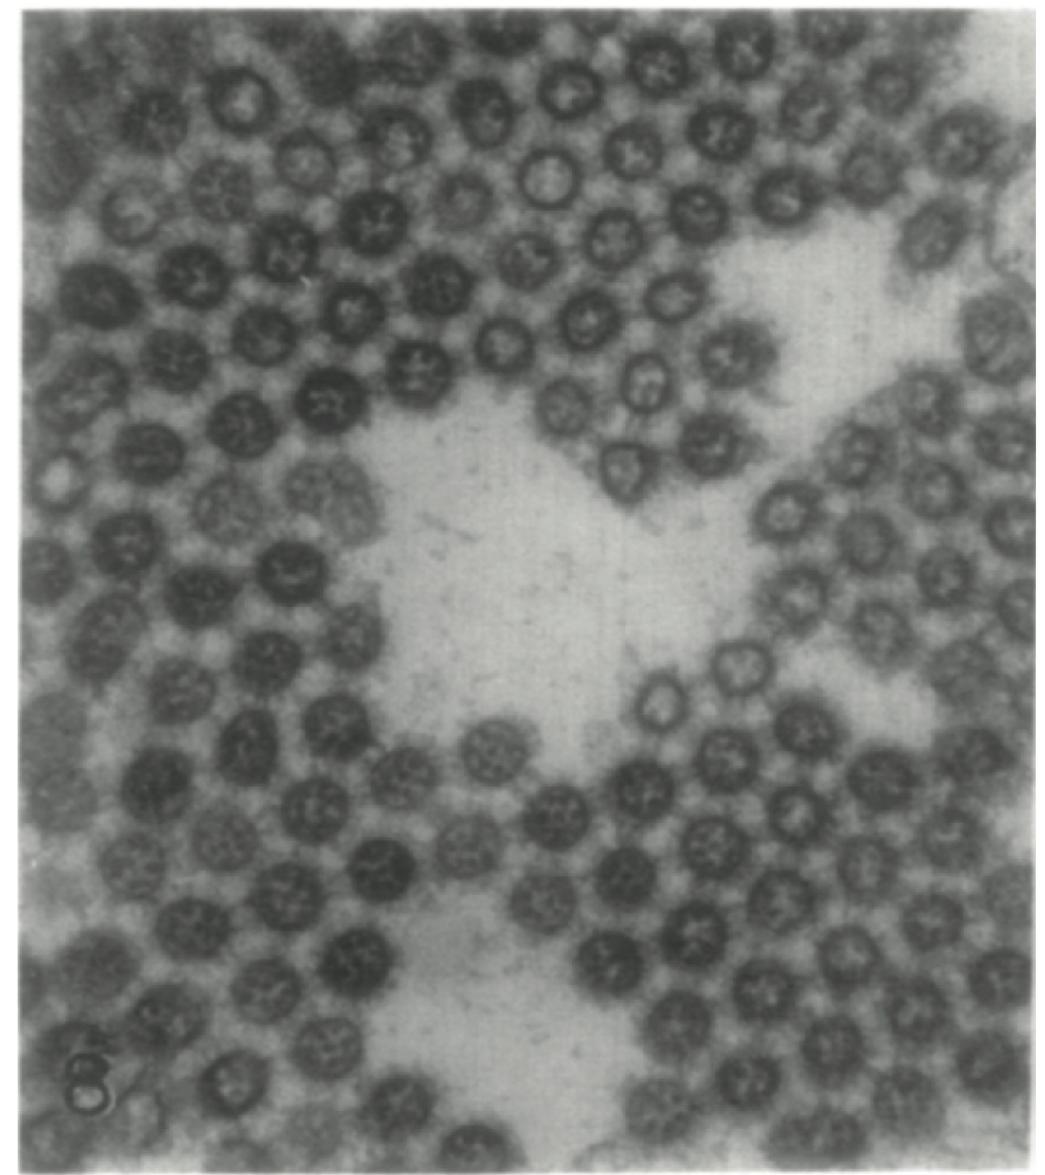
Figure 4. NA is needed for the successful detachment of nascent influenza virus particles from host cells. Shown here is one of the original electron micrographs from the work of Peter Palese et al. (taken with permission from P Palese, Tobita, et al. , 1974), showing the aggregation of influenza virus particles in the absence of neuraminidase activity